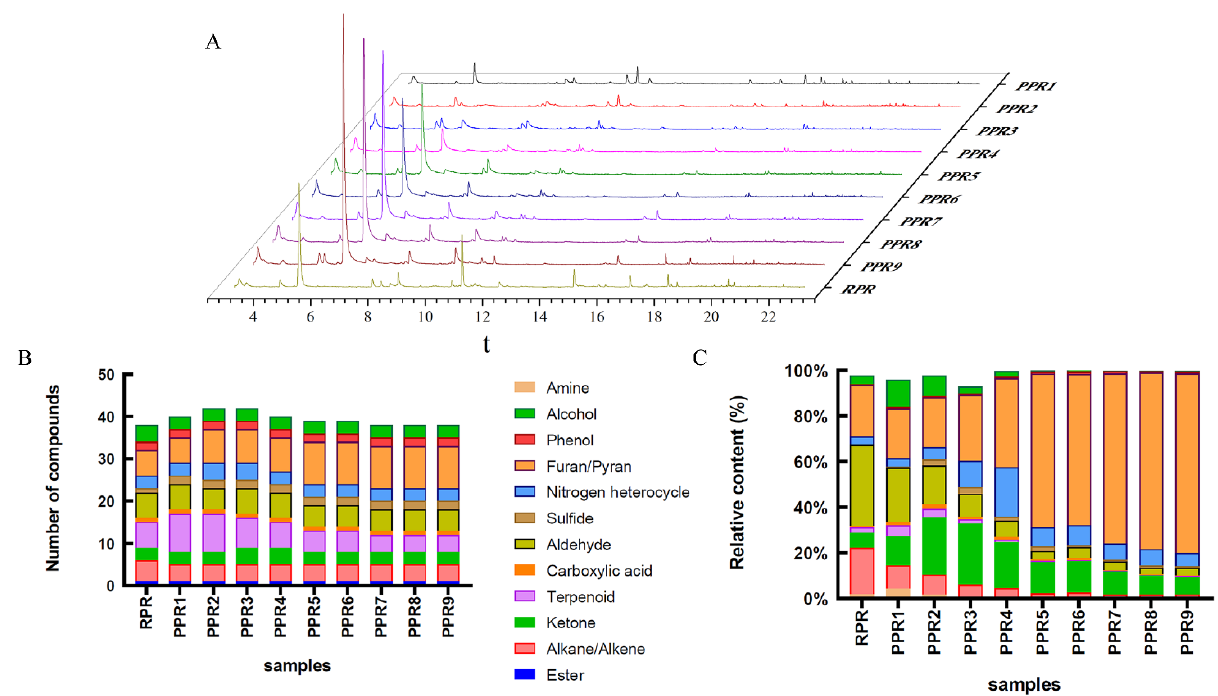
Figure 6. Volatile compounds of PR samples with different processing levels: ( A ) Total ion chro- matograms; ( B ) number of volatile compounds; ( C ) relative content of volatile compounds.